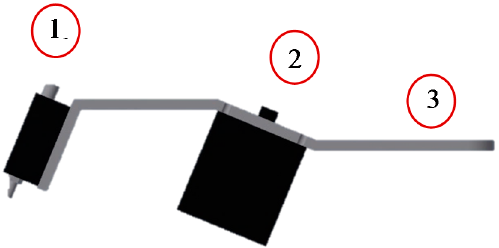
Figure 2. Design of the sensor-lens unit prepared for use in the experiments. Components: 1. True-color sensor with PC interface (RS232), power supply, switching outputs and two optical fibers (emitter and receiver); 2. Lens (double concave, diameter 5 cm, angle 22.5° connector for optical fiber); 3. Space for valve and nozzle.